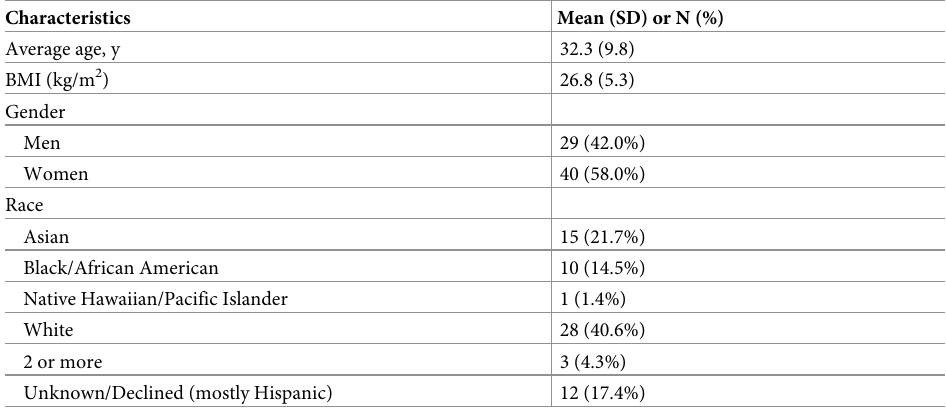
Table 1. Demographics in analytical